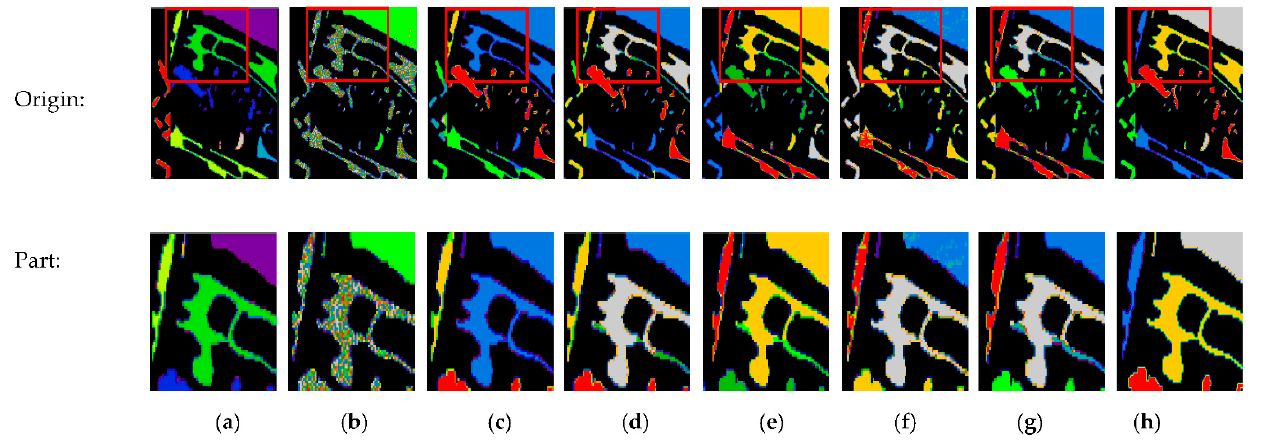
Figure 5. Clustering results obtained using different methods on the Pavia Center data set. ( a ) Ground